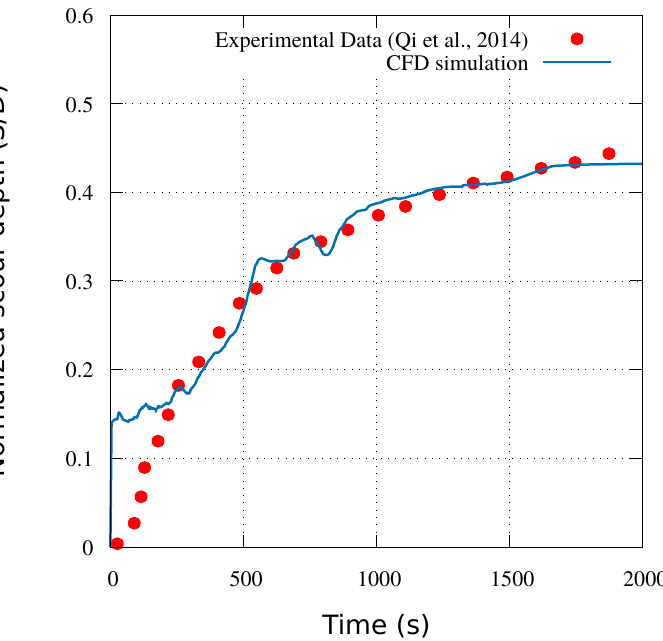
Figure 2. Comparison between the numerical simulations and experimental data obtained by Qi and Gao [34] for the phenomenon of scouring around a pile under the influence of waves and